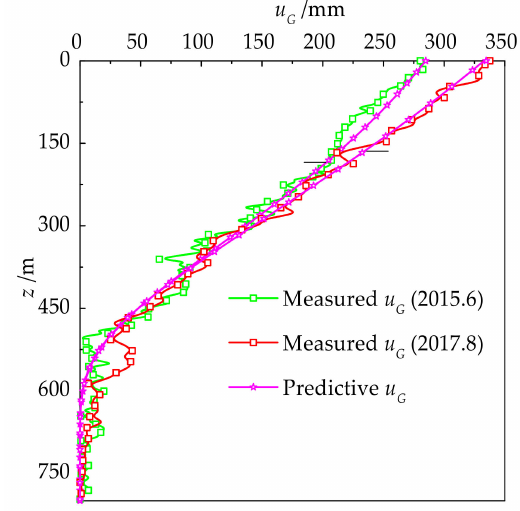
Figure 7. Measured and predictive values of the horizontal